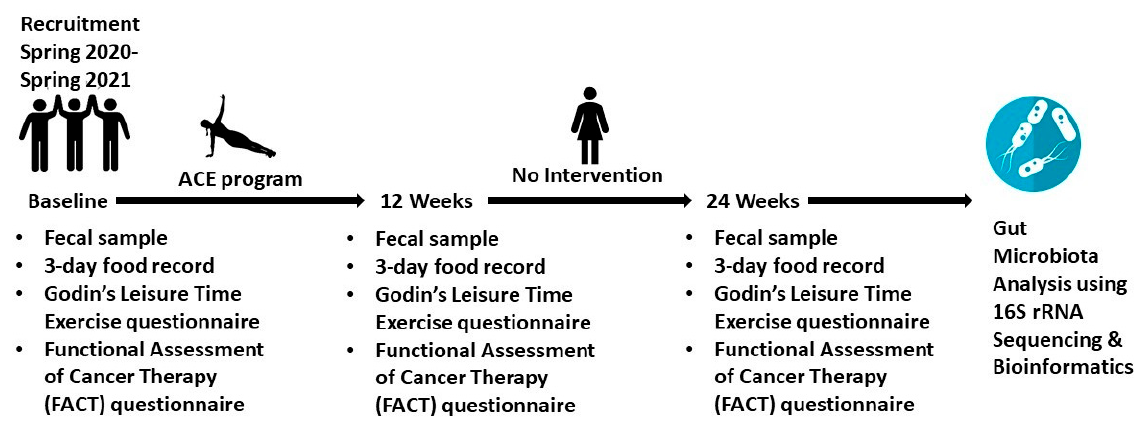
Figure 1. Clinical Study Outline. ACE, Alberta Cancer Exercise.